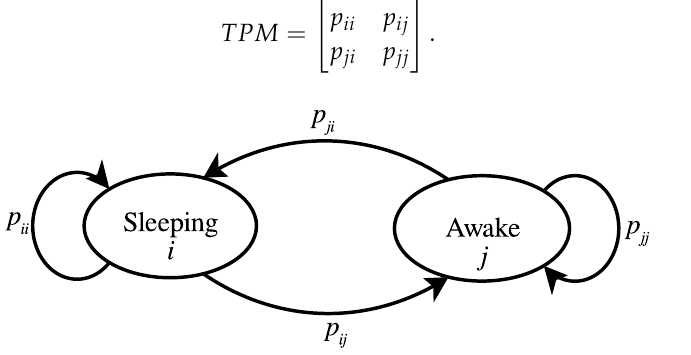
Figure 2. An example of a Markov chain with two